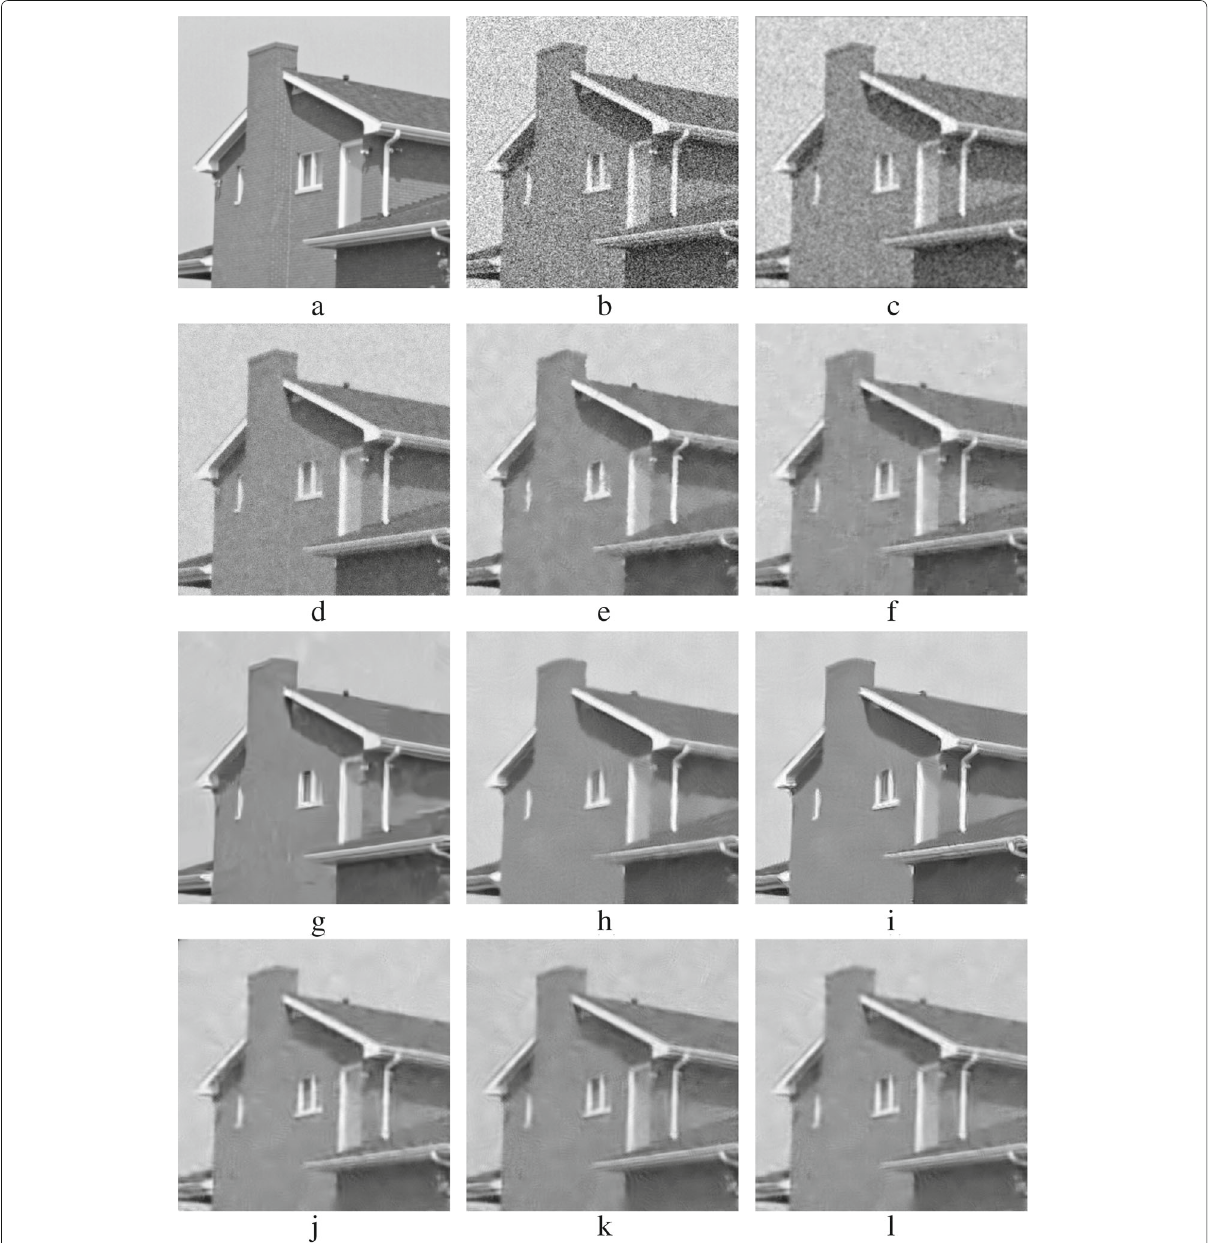
Fig. 18 Denoised House images: a original House image; b AWG noise, σ = 40; c AD (Perona & Malik); d bilateral filtering; e NL-Means filtering; f K-SVD; g BM3D; h Non-itPPB; i It-PPB; j PGPCA; k PLPCA; and l